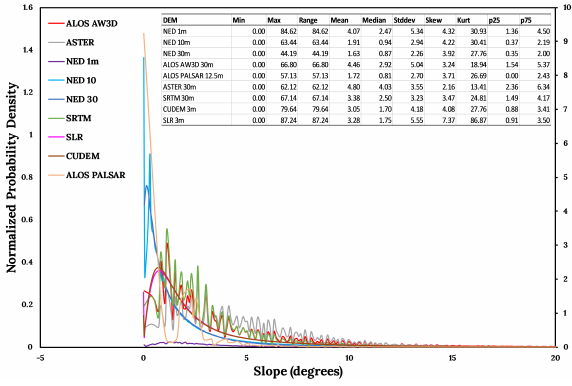
Figure 4. Slope maps for some selected DEMs over study area ution DEMs such as ALOS AW3D, ASTER, and SRTM also showed nearer to high-resolution datasets.